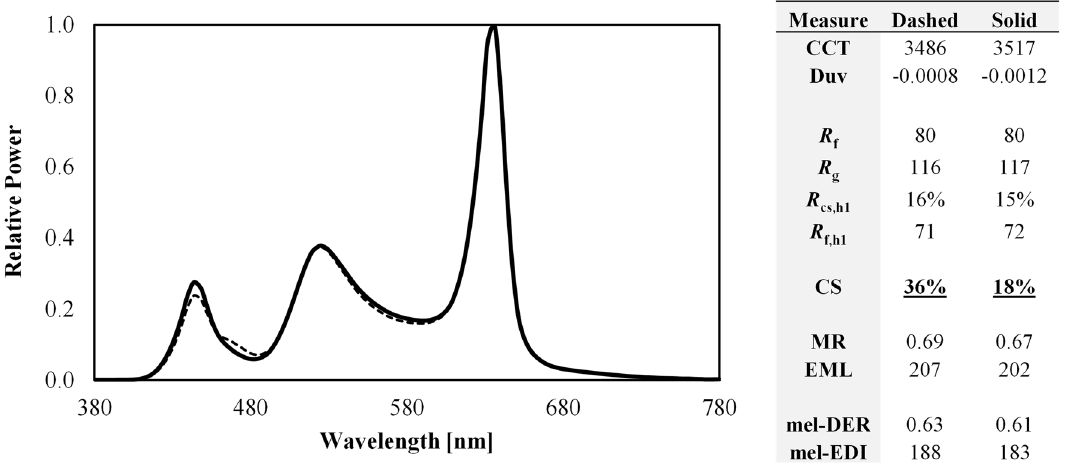
Figure 14. Two spectral power distributions with nearly identical spectral curves (left) but with a CS differing by 100% at a photopic illuminance of 300 lx (right). Because the SPDs are nearly overlapping, the dashed SPD may be difficult to see. For orientation, the largest spectral differences occur near 450 and 480